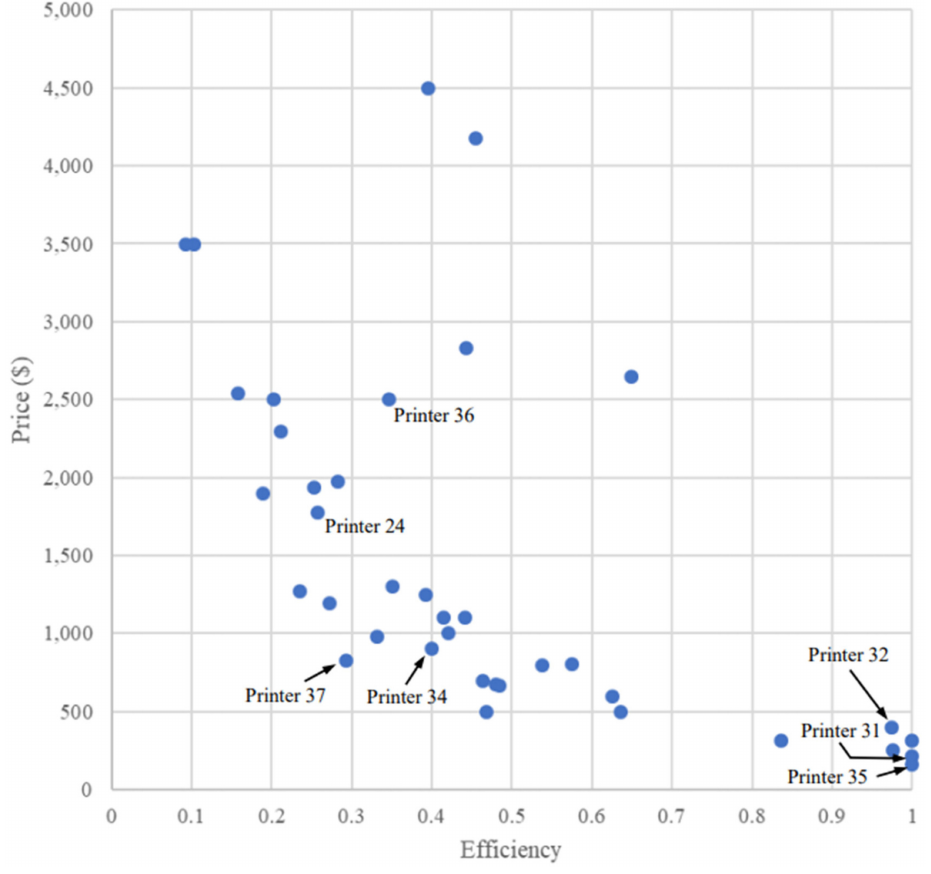
Figure 1. Printer price against